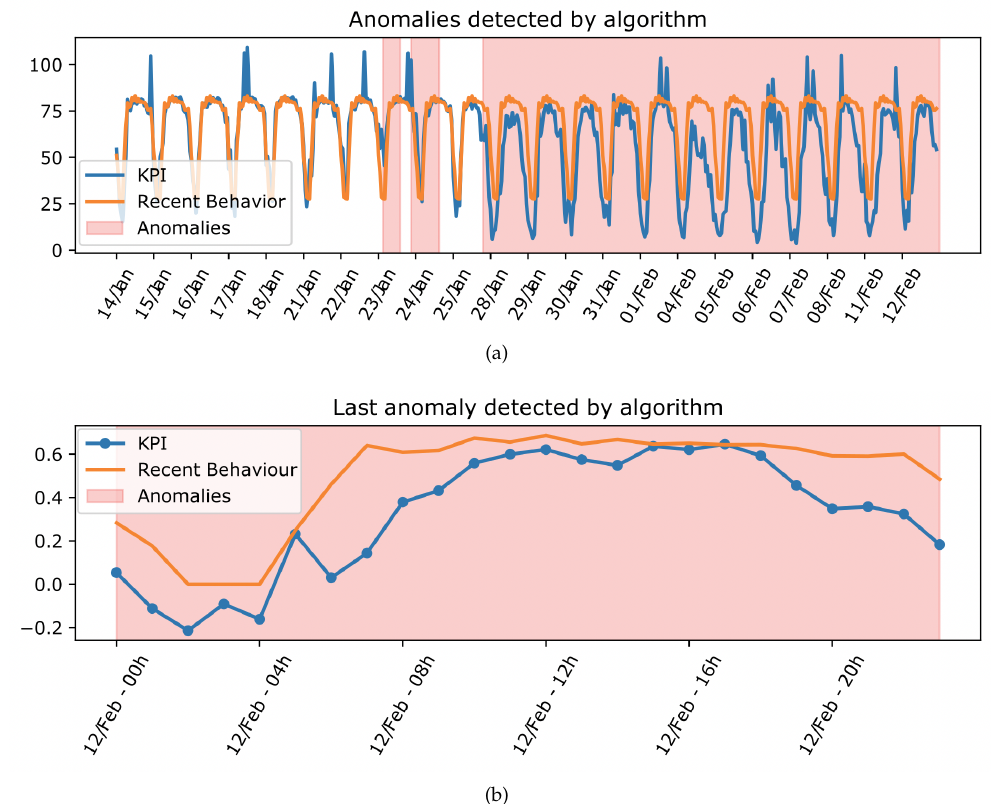
Figure 2. Example of graphics shown to an expert. ( a ) Historical data analyzed; ( b ) Last hours